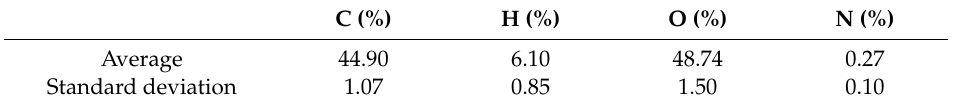
Table 7. Average results of elemental composition of 60 sugarcane bagasse samples (adapted from